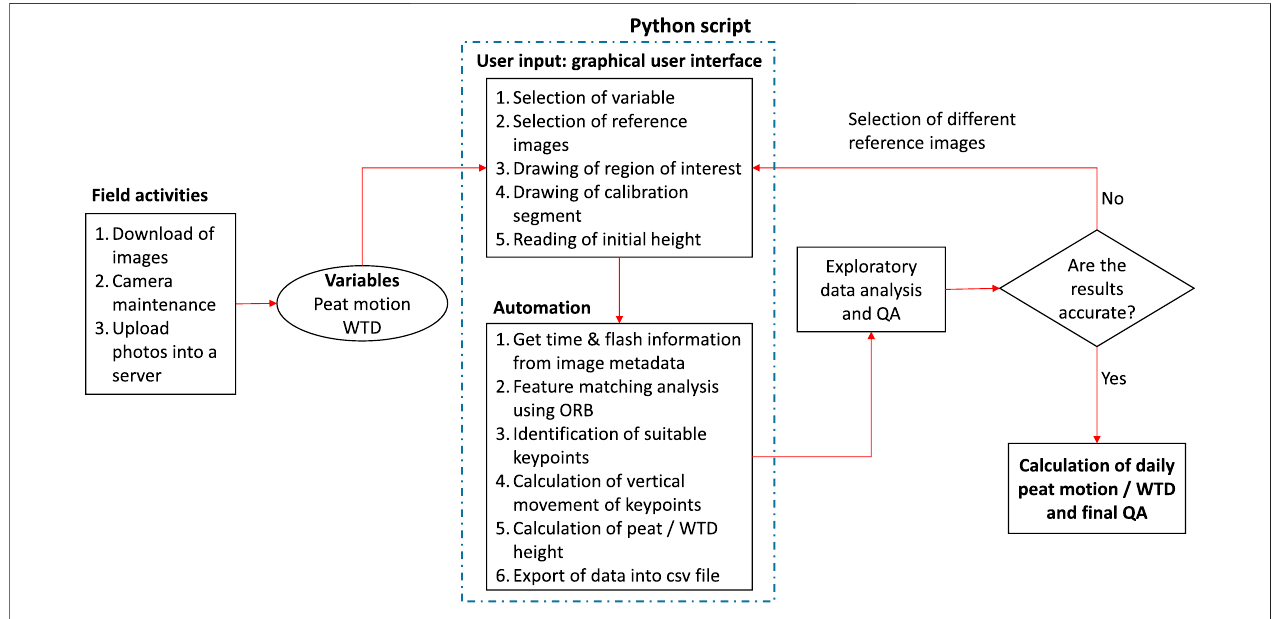
FIGURE 5 | Flow diagram showing procedure for deriving measurements of peat motion and water table depth from image data.